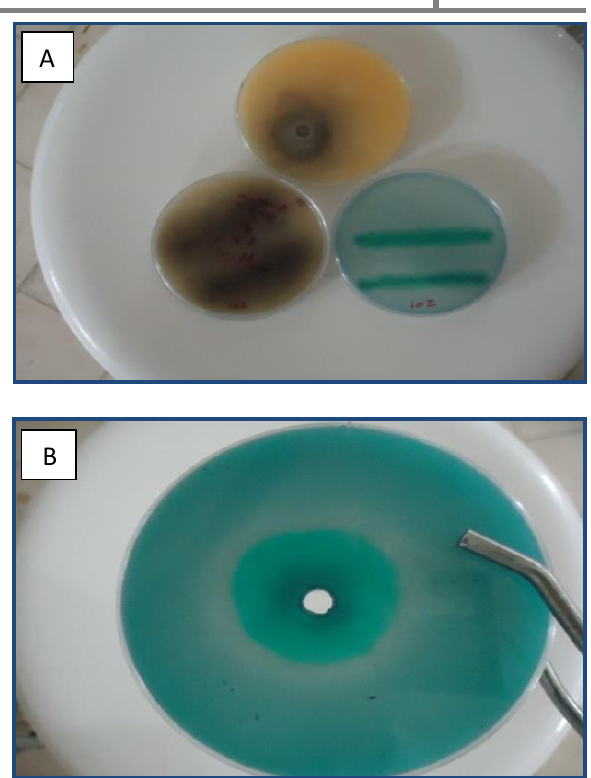
Figure, 1 : P. aeruginosa isolate on agar well diffusion method: A- p. aeruginosa isolate on three different media (EYA, BCL media, and lecithin agar media) B- opaque zone on BCL